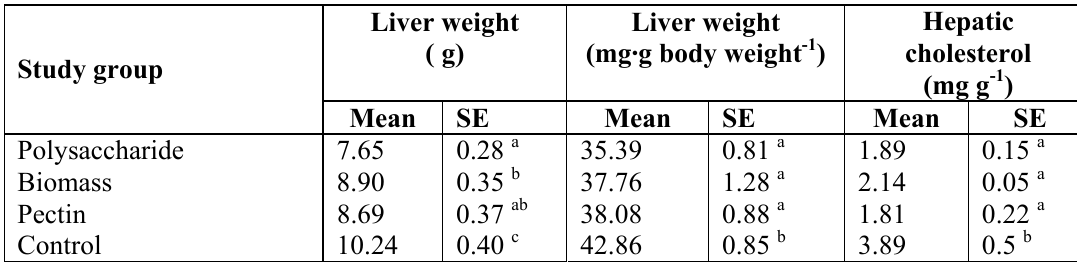
Table 5. Hepatic data for rats (n = 6) fed experimental diets for 15 days. Values in columns with different letters differ significantly, p <